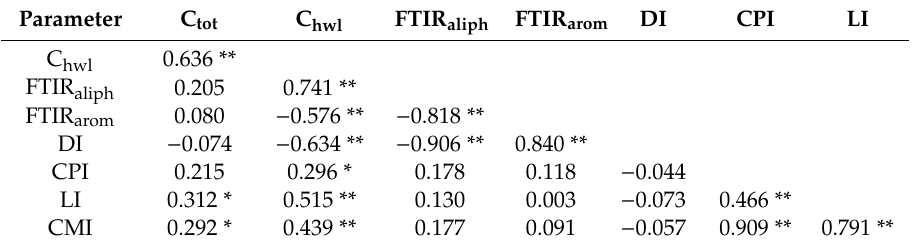
Table 3. Relationships between characterized soil parameters (correlation coe ffi cients R